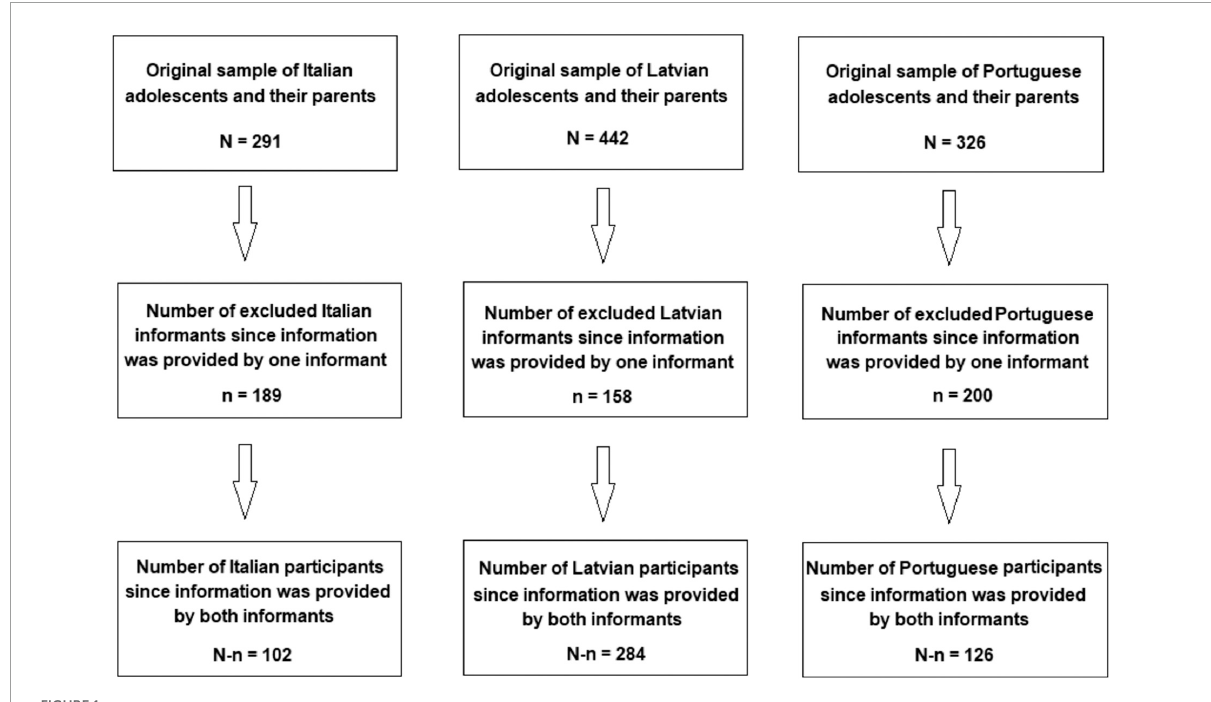
FIGURE1 Flowchart of enrollment in each